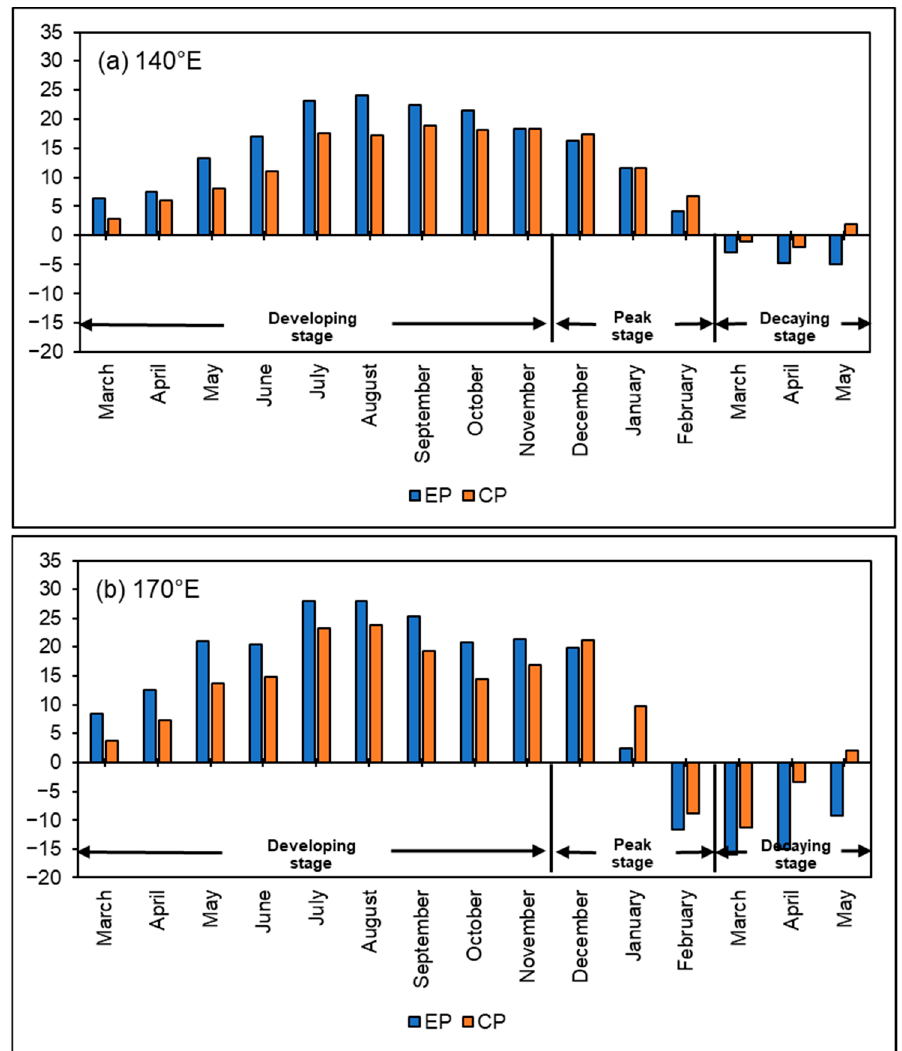
Figure 8. The average transport of zonal flow (Sv) from 1°N to 9°N; for meridional lines 140°E ( a ) and 170 ˚ E ( b ). Eastward and westward flow are indicated by positive and negative values, respec- tively.